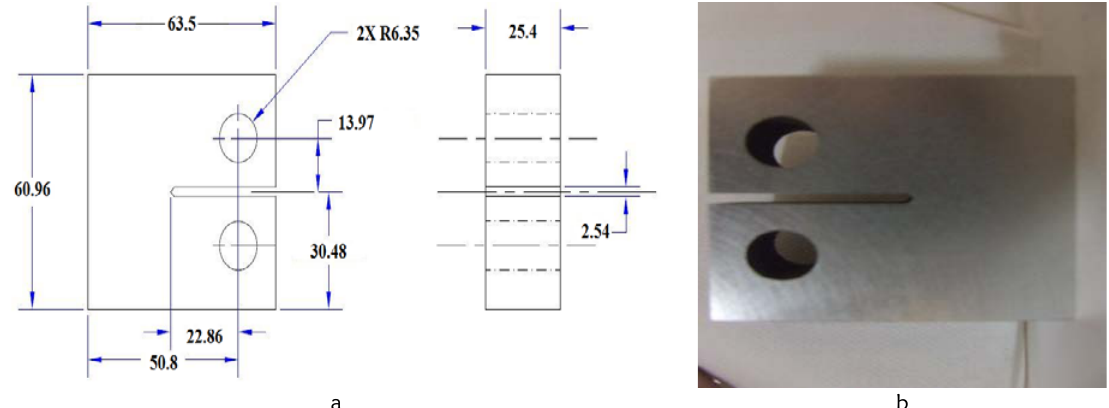
Figure 1: 25.4 mm CT Specimen (a) Specimen Dimensions and (b) Pictorial